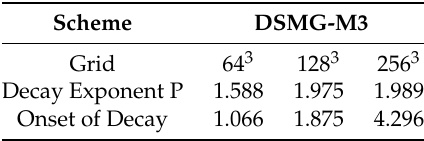
Table 2. Decay exponent and onset of kinetic energy decay obtained using the dynamic Smagorinsky subgrid-scale model with the MUSCL third-order